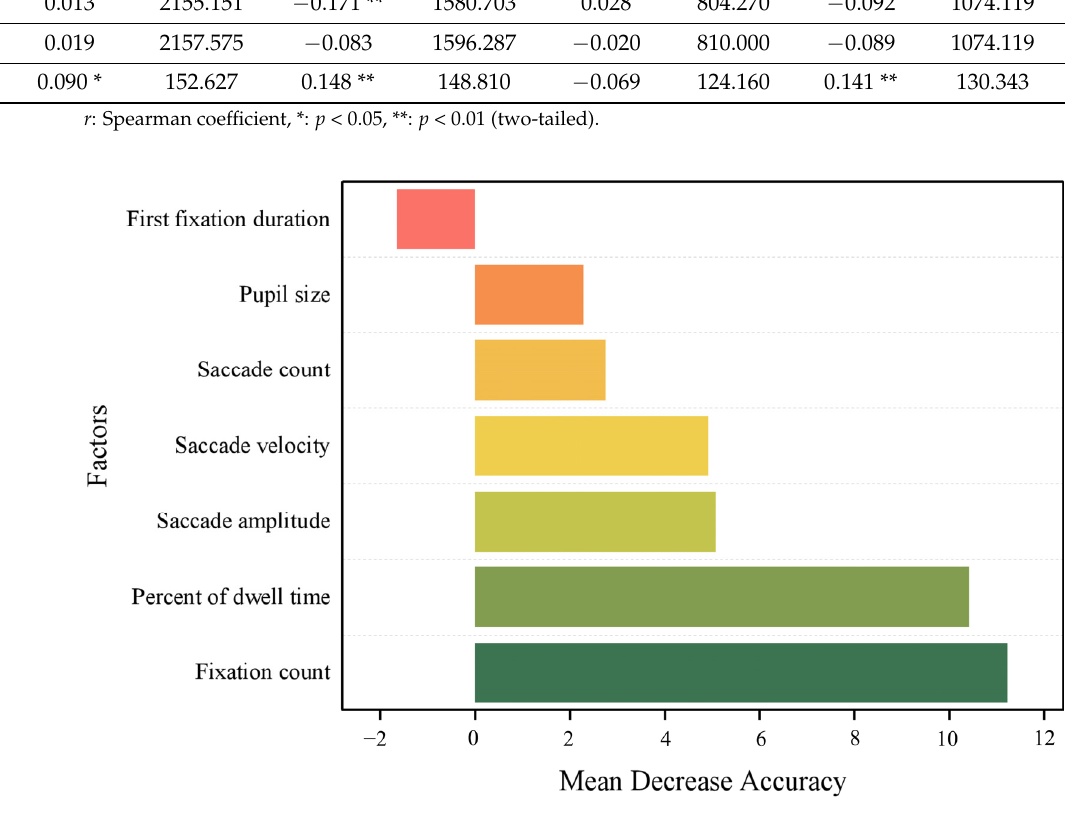
Figure 8. The order of mean decrease accuracy of eye-tracking measures concerning subjective rat- ings.